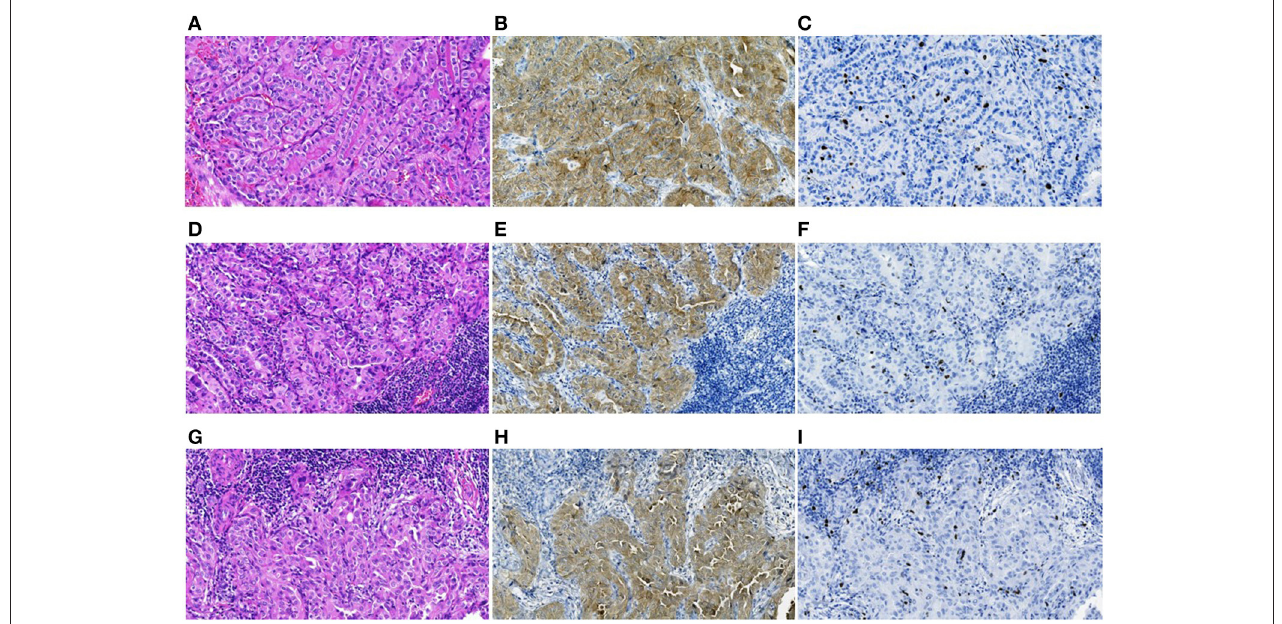
FIGURE 3 | The BRAF V600E -positive radiogenic PTC: (A–C) primary tumor, (D–F) primary lymph node metastasis, and (G–I) an RAI-R recurrent metastasis removed 2.8 years after the first surgery, all images are at 200X magnification. (A) Primary tumor with trabecular-papillary growth pattern, tall cell variant, H&E; (B) positive IHC reaction with anti-BRAF (mutated V600E) antibody; (C) IHC reaction with Ki67 (Clone MIB-1) antibody (Ki67 LI 5.4%). (D) Primary oncocytic cell metastasis with solid-trabecular dominant growth pattern, H&E; (E) positive IHC reaction with anti-BRAF antibody; (F) IHC reaction with Ki67 antibody (Ki67 LI 3.3%). (G) RAI-R recurrent oncocytic cell metastasis with solid-trabecular growth pattern, H&E; (H) positive IHC reaction with anti-BRAF antibody; (I) IHC reaction with Ki67 antibody (Ki67 LI 3.3%).